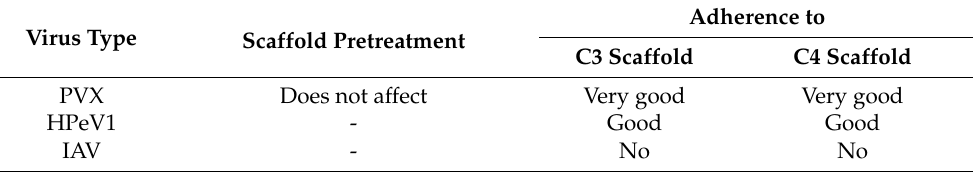
Figure 8. Results of IAV (influenza A virus) binding to GAIN scaffolds (log PFU scale) with original ( a ) and diluted ( b ) virus titres. Error bars show standard error. Table 3. Summary of the virus binding to GAIN